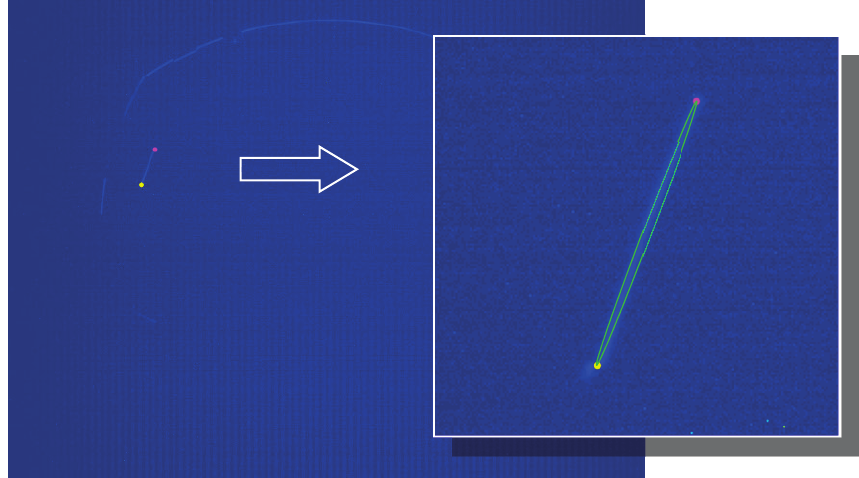
Figure 11. Results of the edge extraction algorithm used for the detection of the board sizes. The inset shows a magnified view of the extracted points; the green line identifies the fitting ellipse.